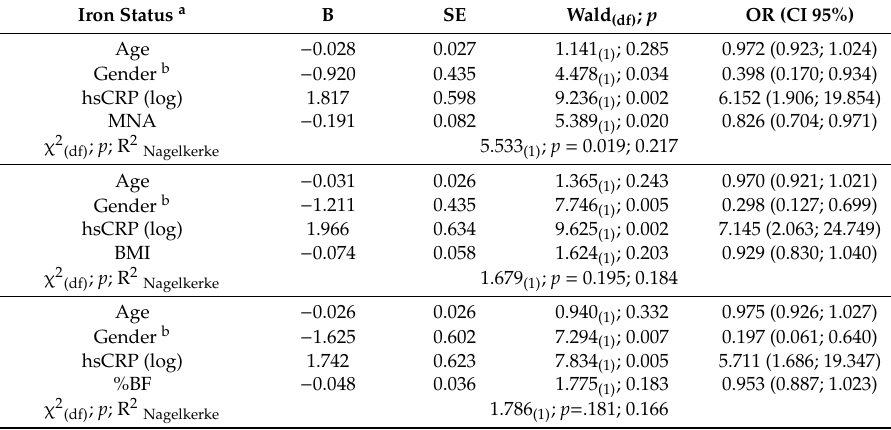
Table A5. Binary logistic models for iron